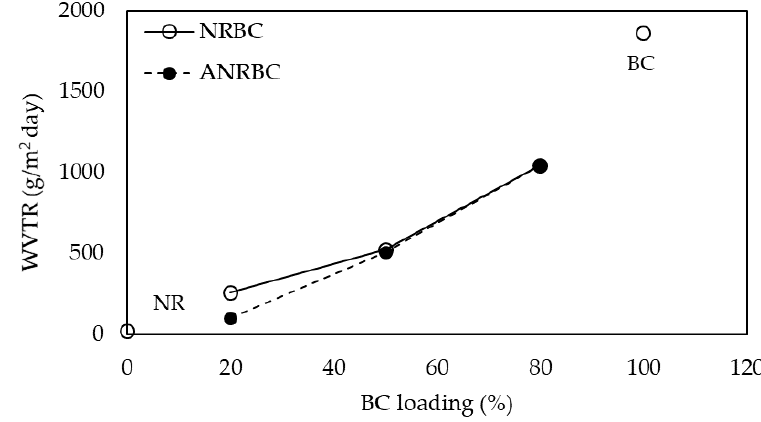
Figure 8. Degree of swelling of NRBC and ANRBC films in toluene ( A ) and water ( B ).